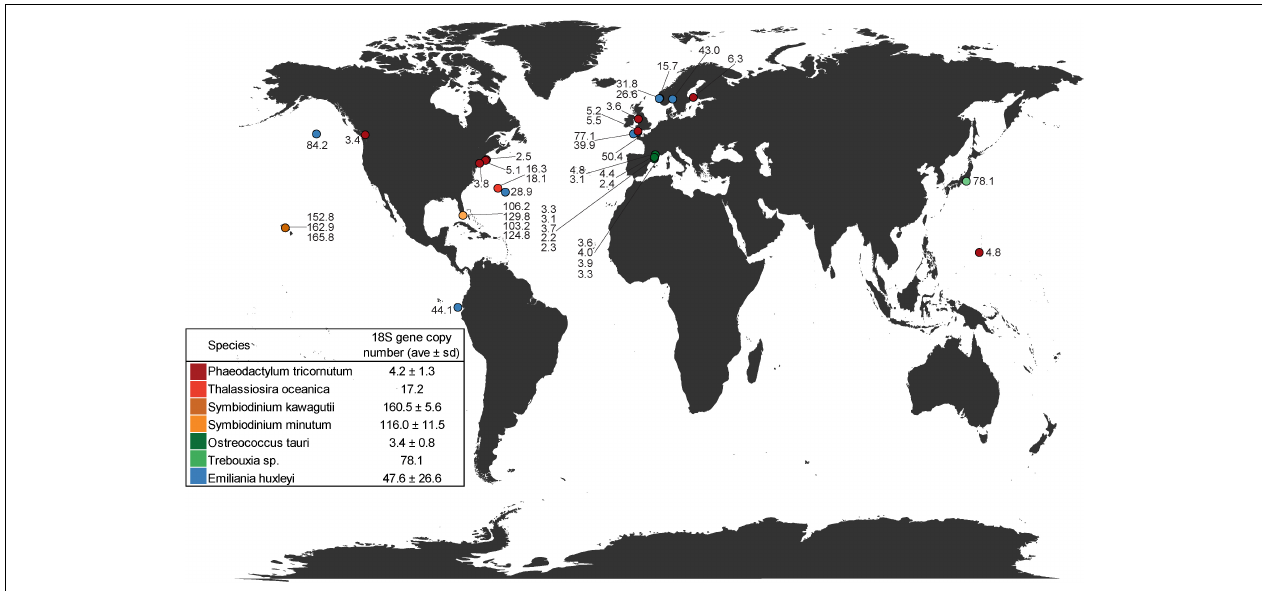
FIGURE 1 | Geographic distribution of 18S gene copy number estimates for representative phytoplankton species with assembled/draft genomes plotted in relation to their isolation location. Symbols with more than one number represent locations in which multiple strains were sequenced. Inset table provides averages ± standard deviation of all strains for each species examined.